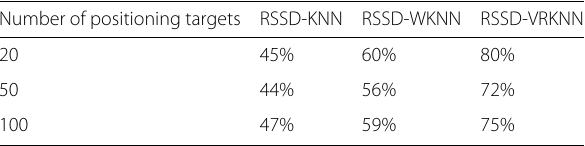
Table 2 The probability of location error ( ≤ 1.5 m) with different numbers of positioning